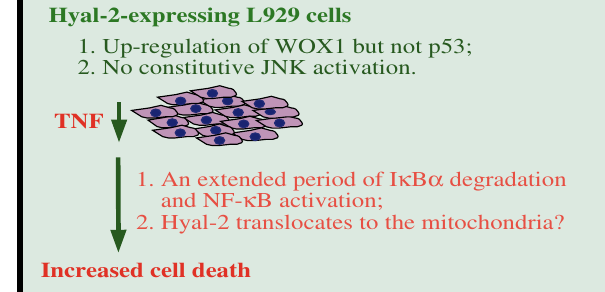
Figure 8 A summarized scheme for Hyal-2-induced TNF susceptibility in L929 cells. Upregulation of proapoptotic WOX1 but not p53 was observed in the Hyal-2-expressing cells. Unlike PH- 20, Hyal-2 could not induce constitutive JNK activation.